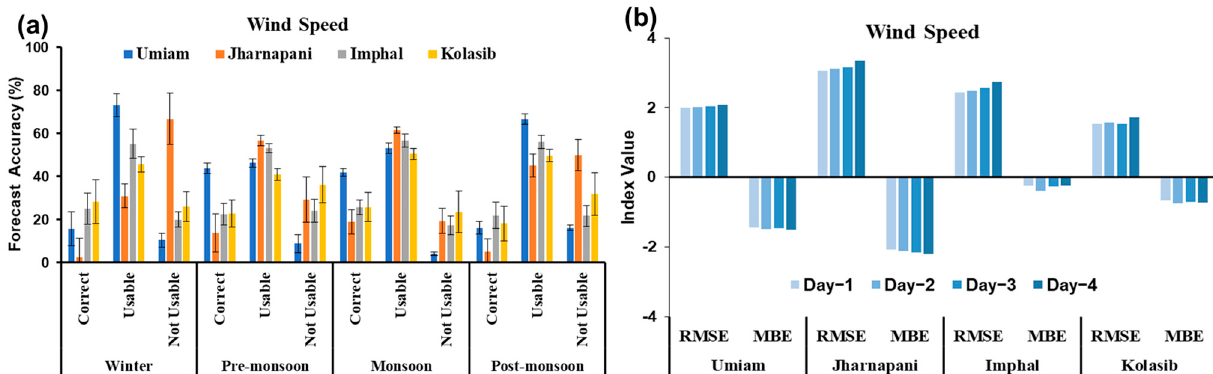
Figure 6. Quantitative ( a ) and statistical evaluation ( b ) of wind speed forecast over various locations of the northeastern hill region of India.